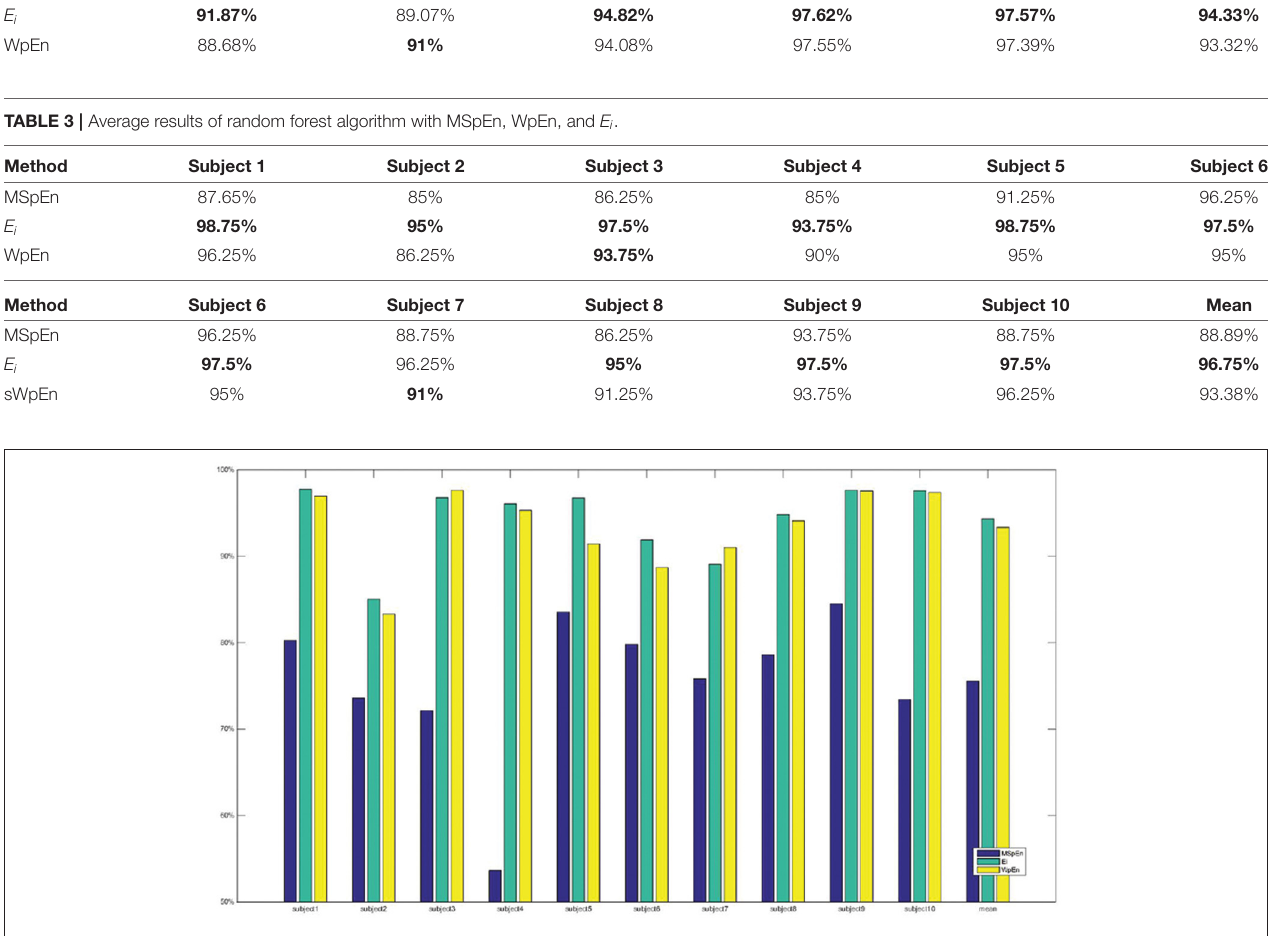
FIGURE 4 | Comparison of classification accuracy with three features and decision tree